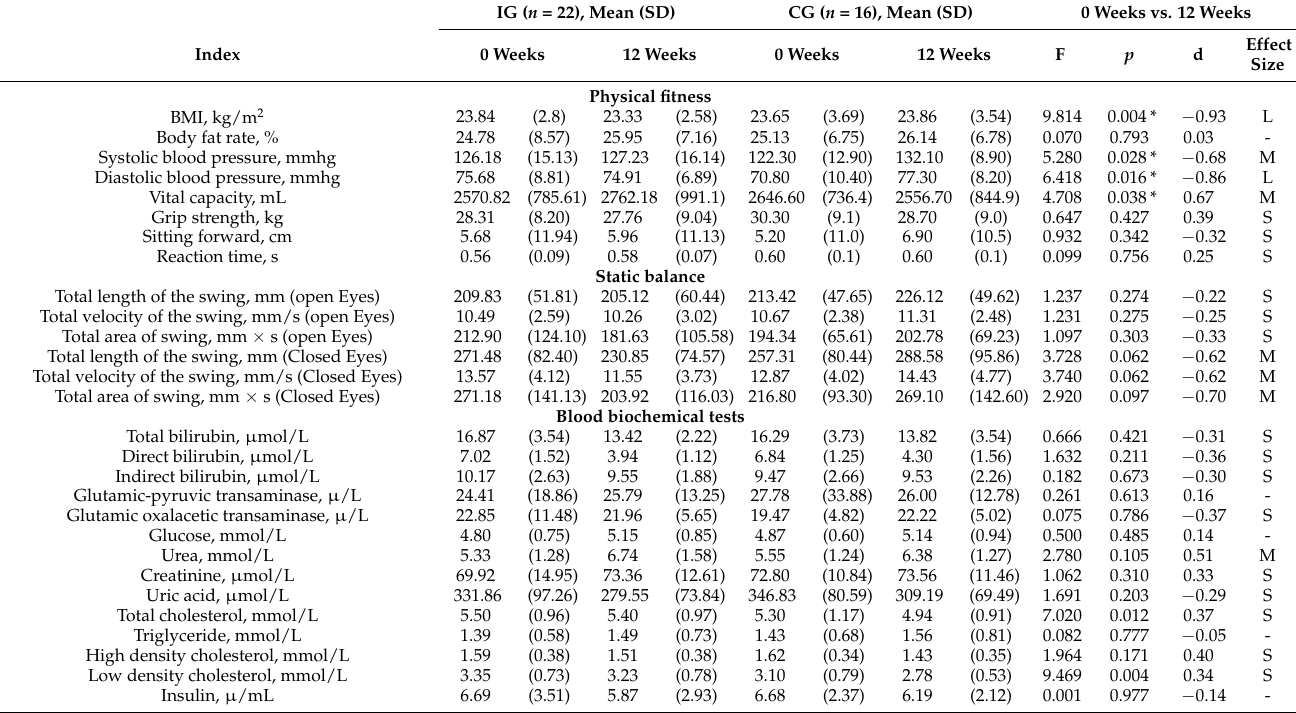
Table 2. Baseline (0 weeks), post-test (12 weeks) change for physical fitness